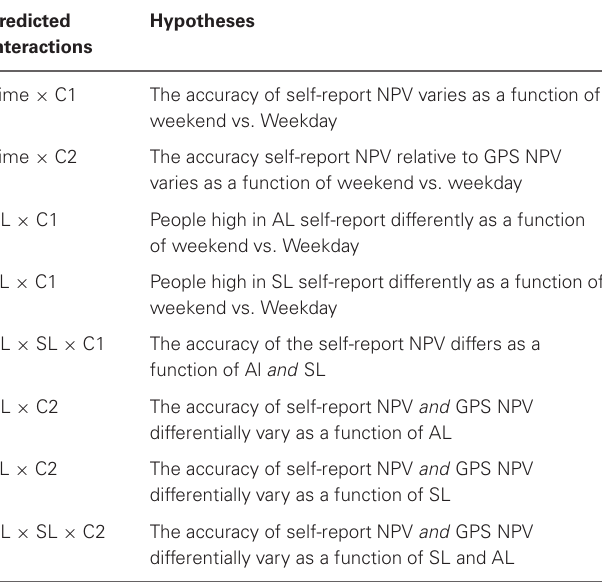
Table 2 | Convergent validity hypotheses tested by the interaction